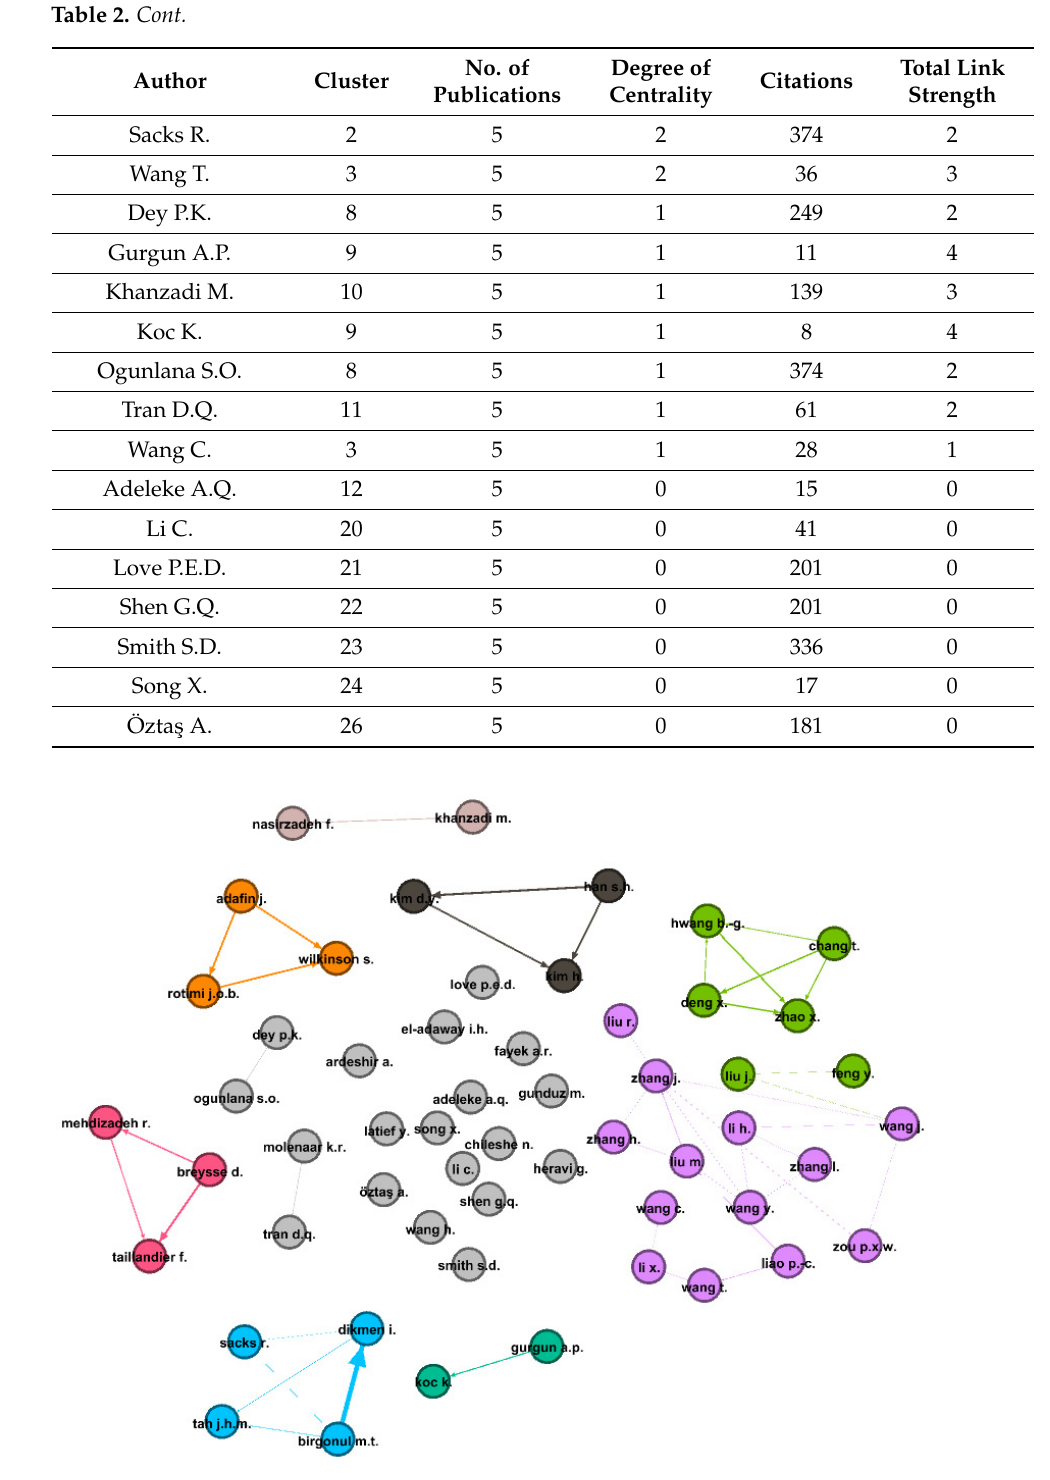
Figure 5. Most productive authors in risk management in